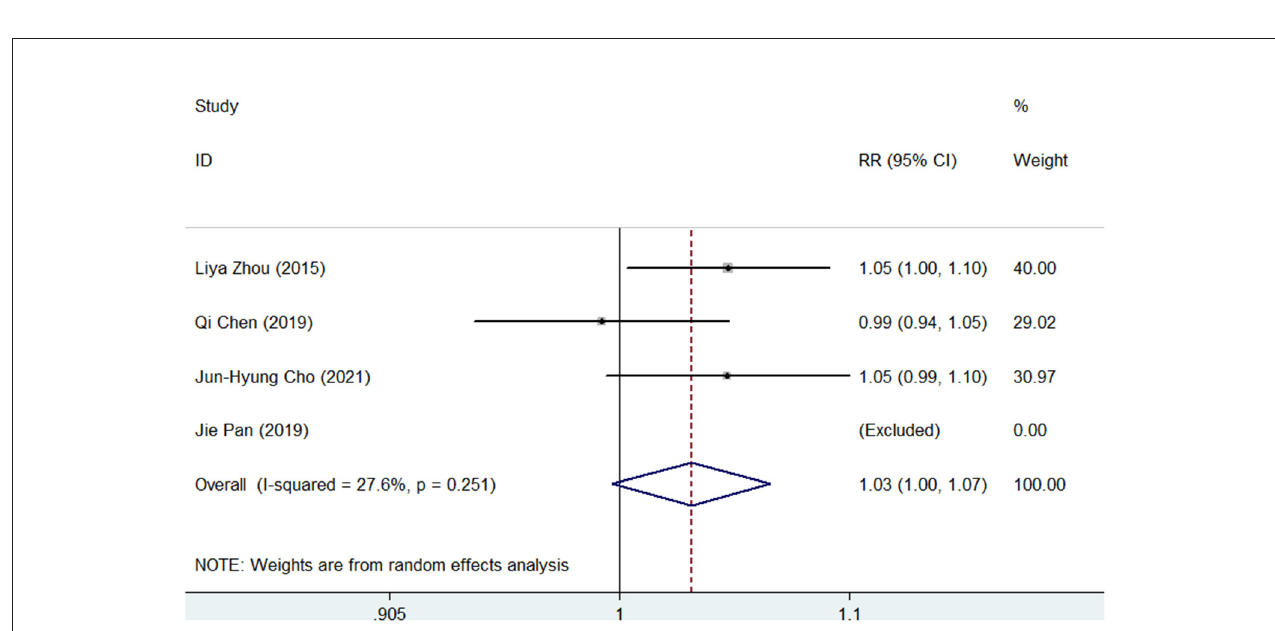
FIGURE 6 | Forest plots for the comparison of SGT vs. BQT in